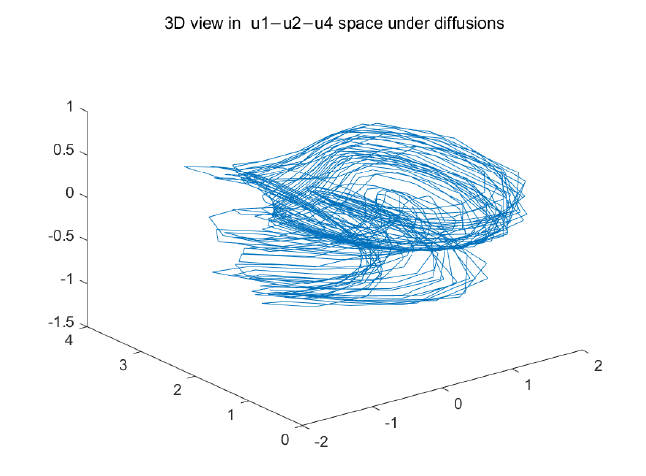
Figure 1. Computer simulations of chaos of financial system under diffusions.